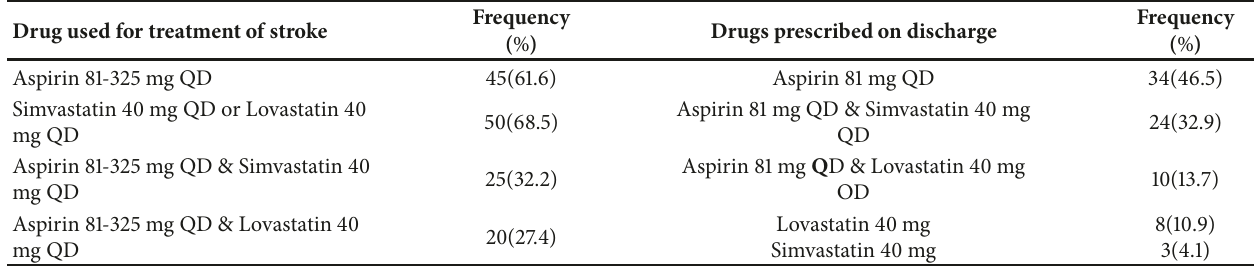
Table 2: Medications used by stroke patients during hospitalization and discharge at Shashemene Referral Hospital, 2012–2017 (N=73). Drug used for treatment of